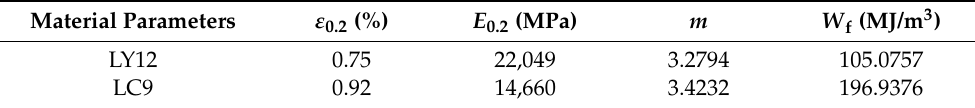
Table 2. ε 0.2 , E 0.2 , m and plastic strain energy densities.